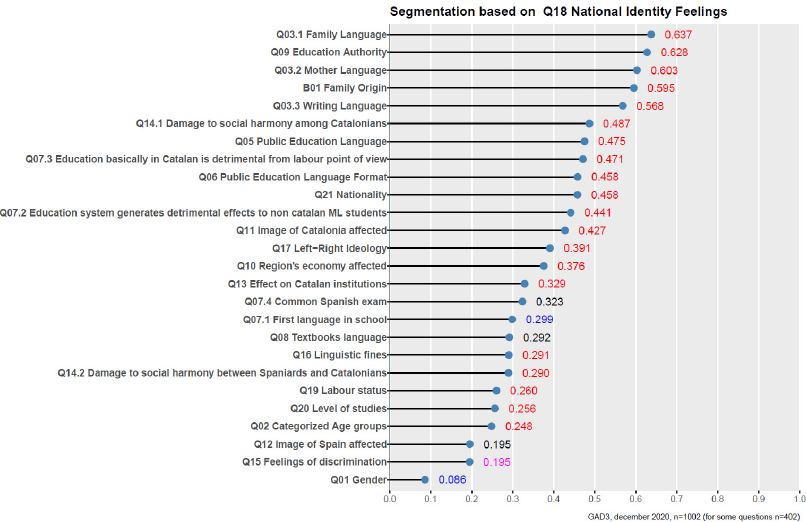
Figure 4. Differences between Catalonians sorted by their “ feelings of national identity ” segment and each of the remaining variables surveyed. The numerical values and lengths of the bars correspond to the contingency coefficient C reported in Table 4. Variables are sorted by their C values. The different colours of the figures correspond to p ‐ values that are less than 0.001 (red), between 0.001 and 0.01 (magenta), between 0.01 and 0.05 (black), or just over 0.05 (blue).